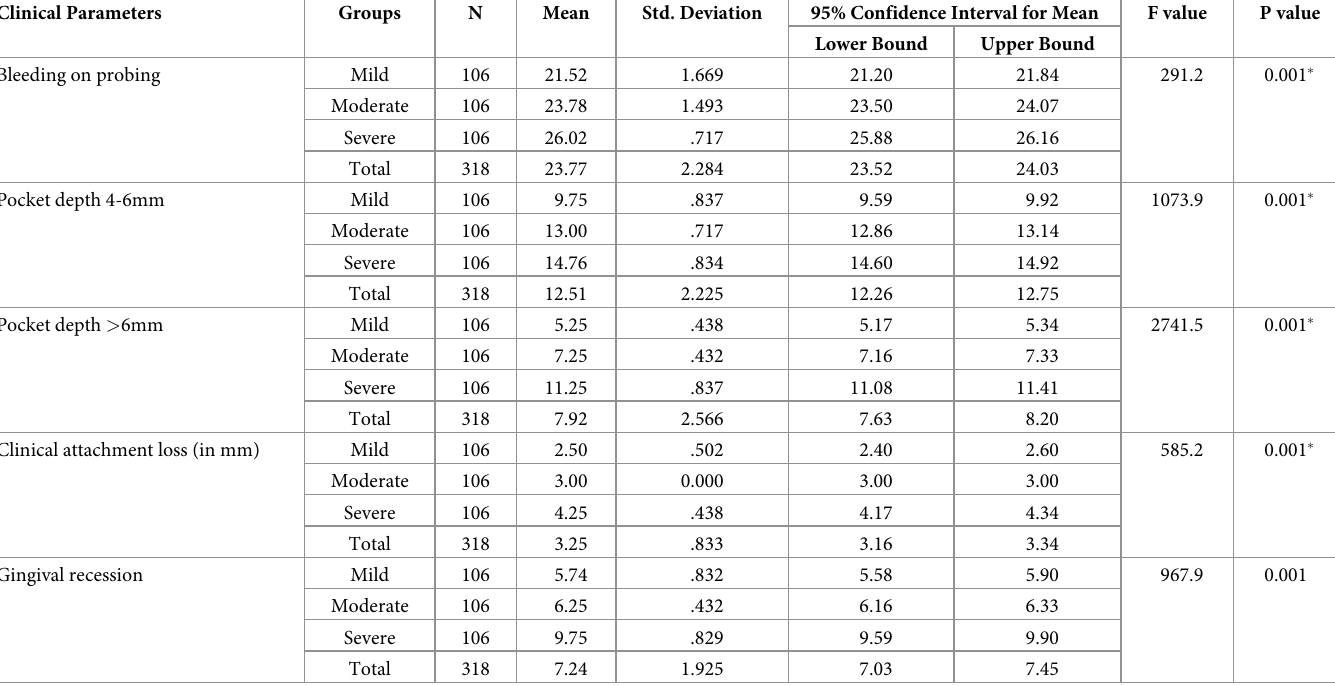
One-way ANOVA; statistical significance at p � 0.05; � indicates high statistical